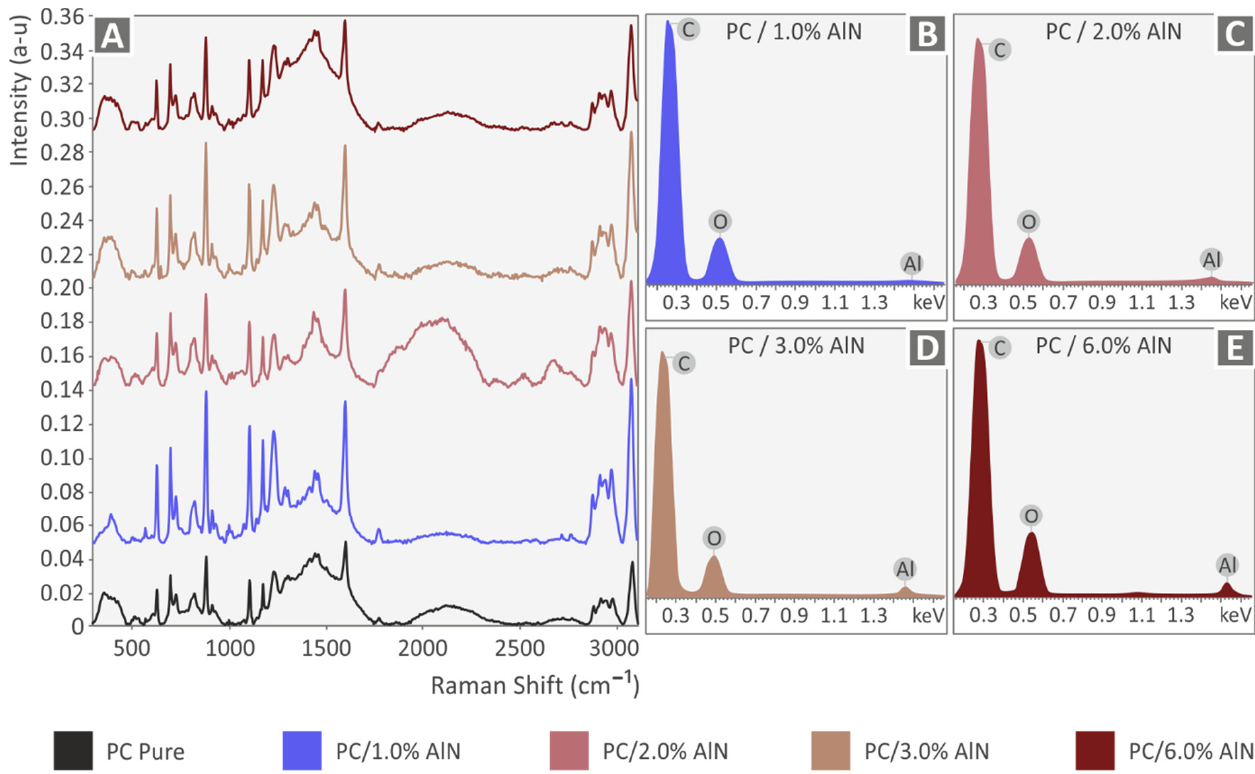
Figure 5. ( A ) Raman spectra for all materials, EDS analysis for nanocomposites with ( B ) 1 wt.% AlN, ( C ) 2 wt.% AlN, ( D ) 3 wt.% AlN, and ( E ) 6 wt.% AlN.